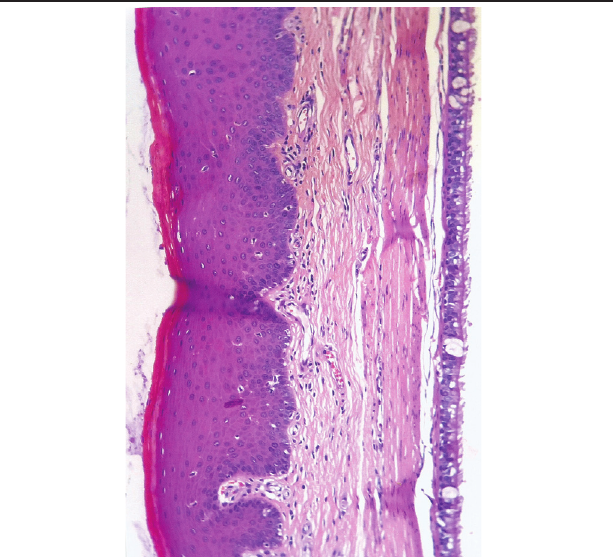
Figura 4 − Corte da lesão corado em HE HE: hematoxilina e